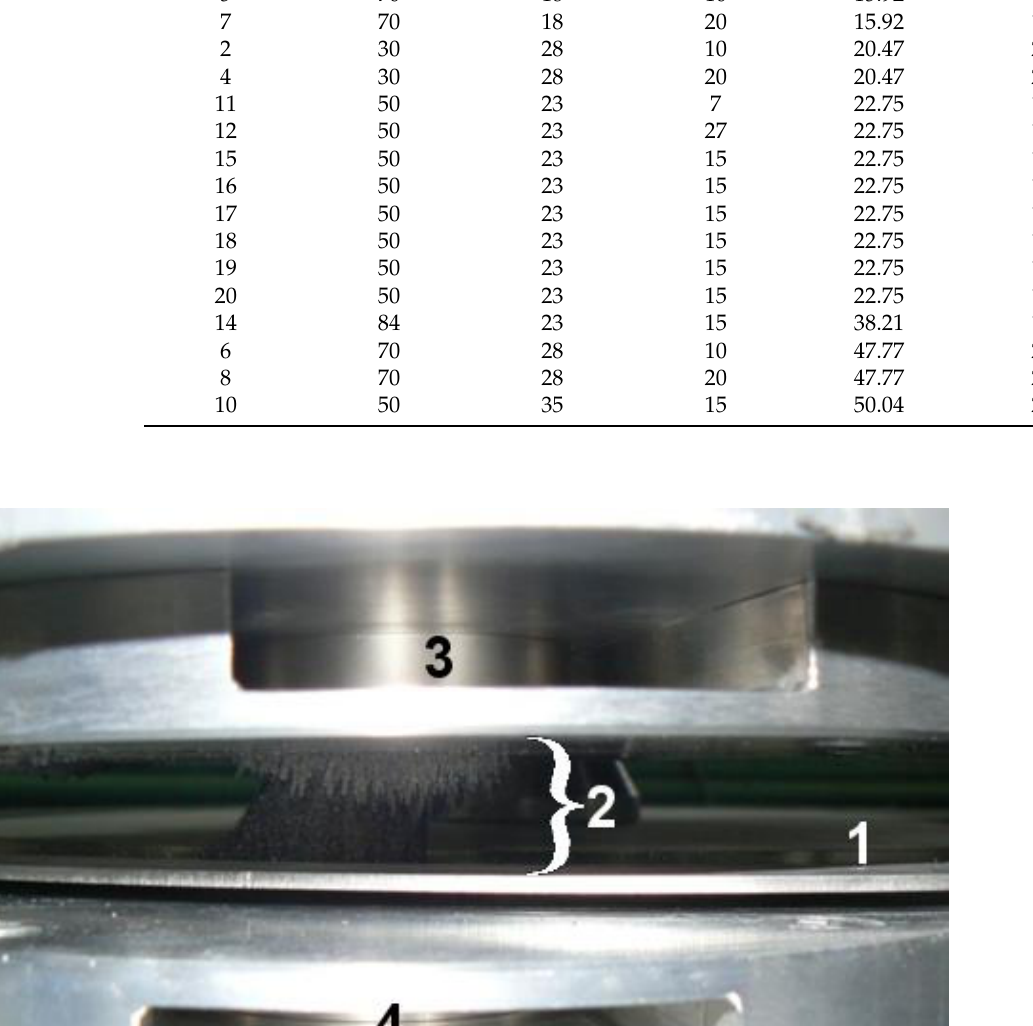
( b ) Figure 9. Mesh of finite elements ( tetrahedrons, quality 0.748, aspect ratio 2.319, skewness 0.329, orthogonal quality 0.675 ): ( a ) experimental station; ( b ) densification on the surface of the separators in m . Figure 10 shows the magnetic flux density vector image for three magnets in the stack. A significant concentration of field density can be observed in the machining gap zone and in the lower part of the base where the maximum magnetic flux density value occurs. This is the result of a high concentration of field lines in a strongly curved section of the magnetic circuit. You can also see the magnetic fringe field on the right side, closing